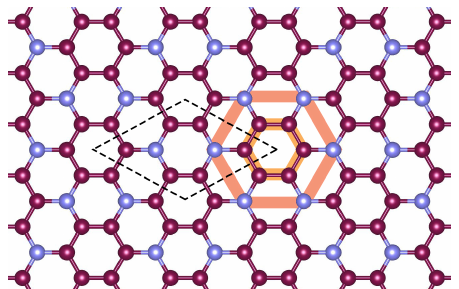
Figure 1. Crystal structure of C 3 N monolayer. Purple and blue circles refer to carbon and nitrogen atoms, respectively. Dashed black lines show the unit cell. The orange line show the hexagonal unit cell, which can be useful for understanding certain optical properties; see Section